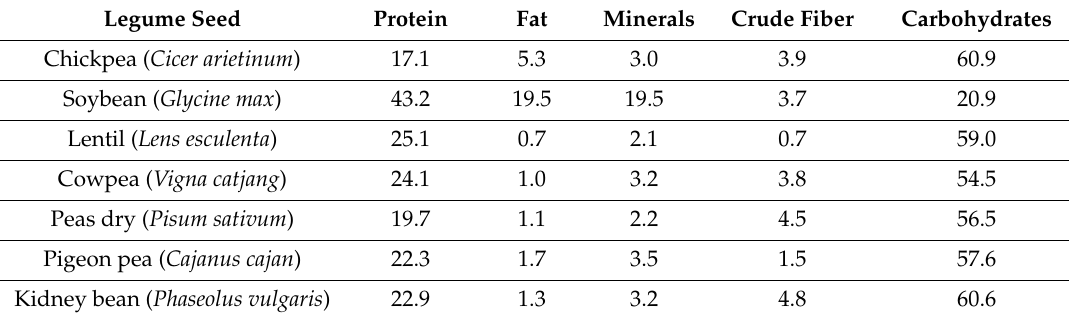
Table 1. Nutritional composition of di ff erent legume seeds (values in